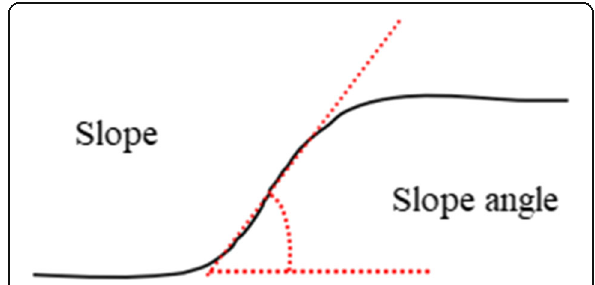
Fig. 7 Effect of slope on ground motion (Vittoz et al.